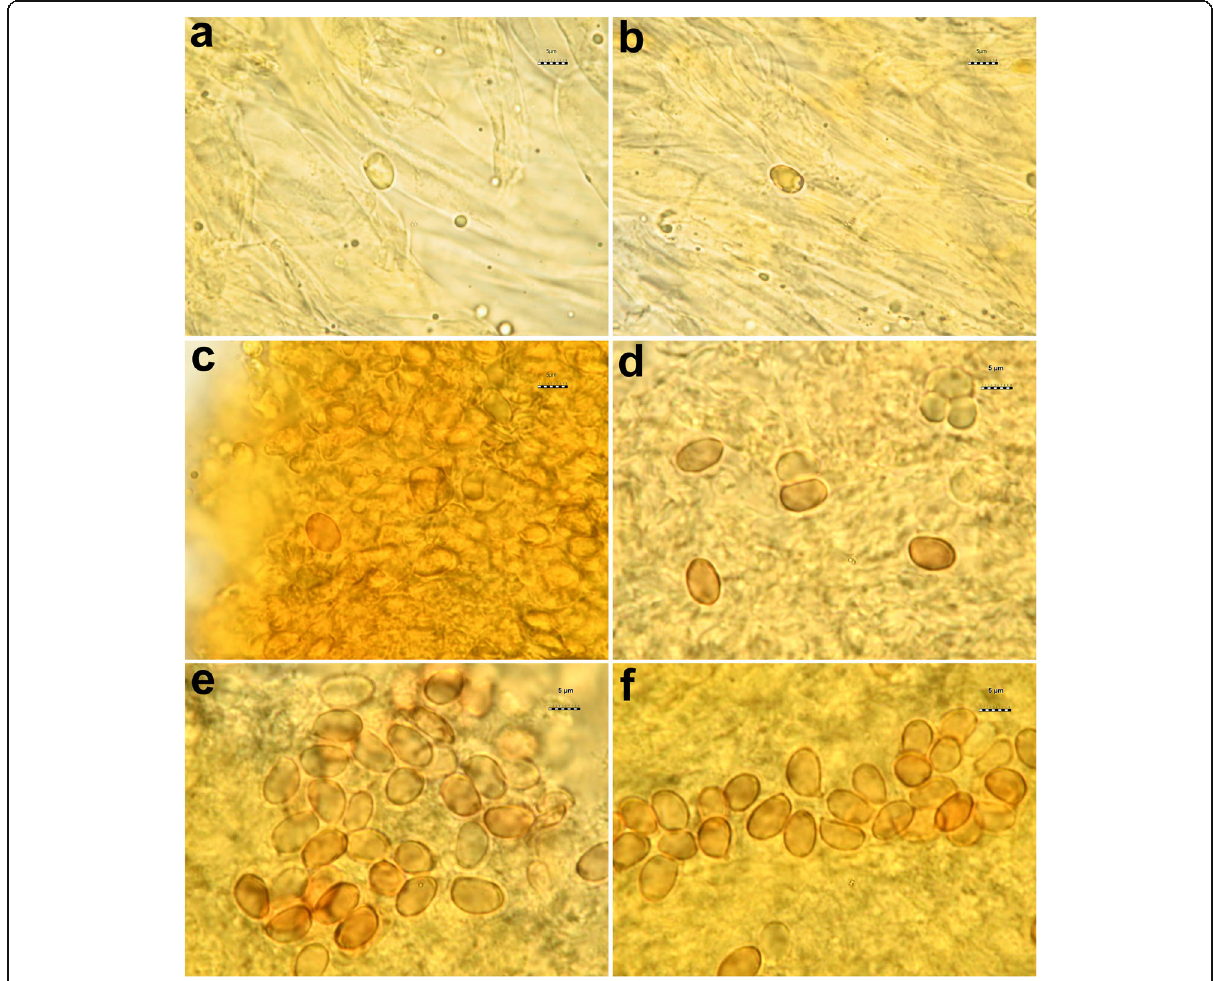
Fig. 6 Spores of Tricholoma terreum (AMB 17444). a – d Observed in Melzer ’ s without pre-heating. a – b Sample soaked in 5% ammonia and observed in Melzer ’ s immediately after squashing; c – d Sample soaked in 5% ammonia and observed after leaving the sample in Melzer ’ s for 30 min. e – f Observed in Melzer ’ s with pre-heating. Photos by L.